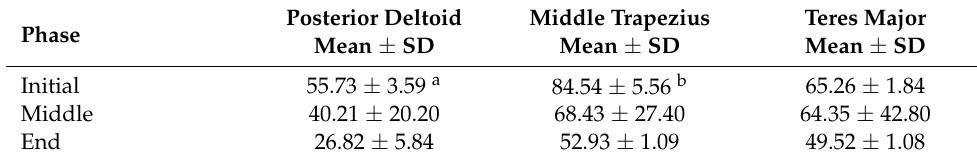
Table 5. Summary of muscle activities (%MVIC) of PD, MT, and TM in three